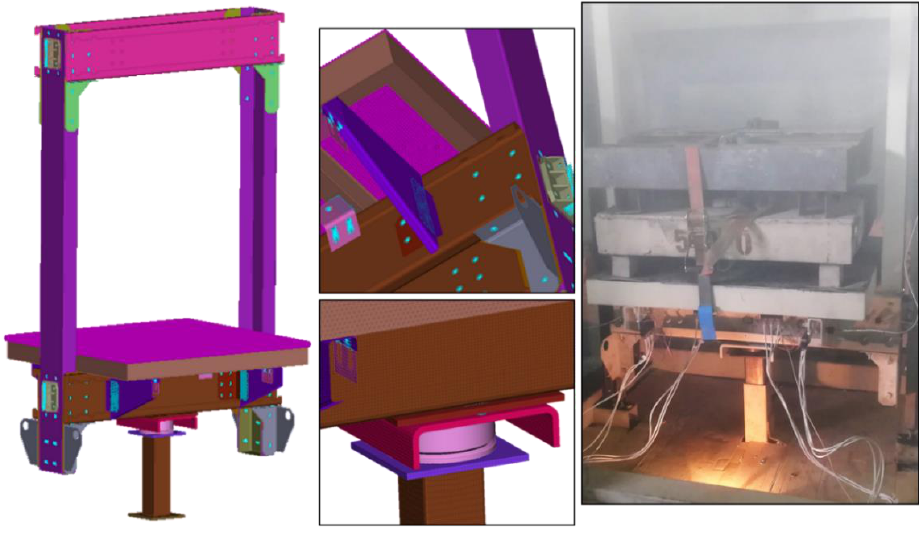
Figure 6. Elevator System, ( left ) Finite Element Model and ( right ) Experimental set-up.